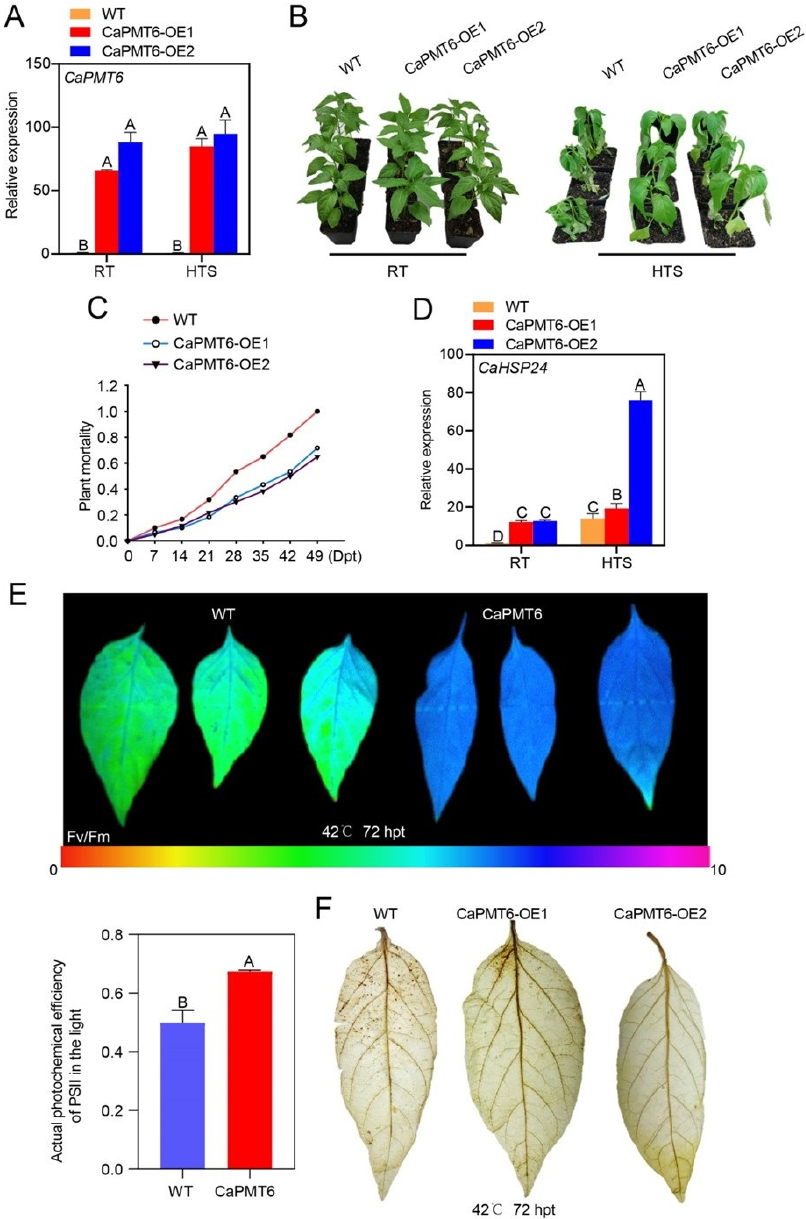
Figure 6. Overexpression of CaPMT6 significantly enhanced pepper thermotolerance. ( A ) The relative transcript level of CaPMT6 in the two transgenic lines were significantly higher than that in the wild type pepper plants; CaActin was used as an internal control; the transcript levels of wild type/RT was set to 1. ( B ) The two CaPMT6 overexpressing pepper lines exhibited enhanced thermotolerance compared with the wild type plants. ( C ) CaPMT6 overexpressing pepper plants exhibited higher mortality upon HTS compared with the wild type plants; a total of 20 plants were calculated. ( D ) The relative transcript level of CaHSP24 in CaPMT6 -overexpressing pepper plants was significantly higher than that in wild type pepper plants; CaActin was used as an internal control; the transcript levels of wild type/RT was set to 1. ( E ) HTS-challenged CaPMT6 -overexpressing pepper plants exhibited increased optimal/maximal photochemical efficiency of PSII in the dark (Fv/Fm) and increased actual photochemical efficiency of PSII in the light ( Φ PSII ) compared with wild type pepper plants. ( F ) Lower level of H 2 O 2 accumulation displayed by darker DAB staining was found in the CaPMT6 -overexpressing pepper plants compared with the wild type pepper plants. In ( A , D , E ), data are shown as means ± standard error of eight replicates; different capital letters above the bars indicated significant differences among means ( p < 0.01), as calculated with t